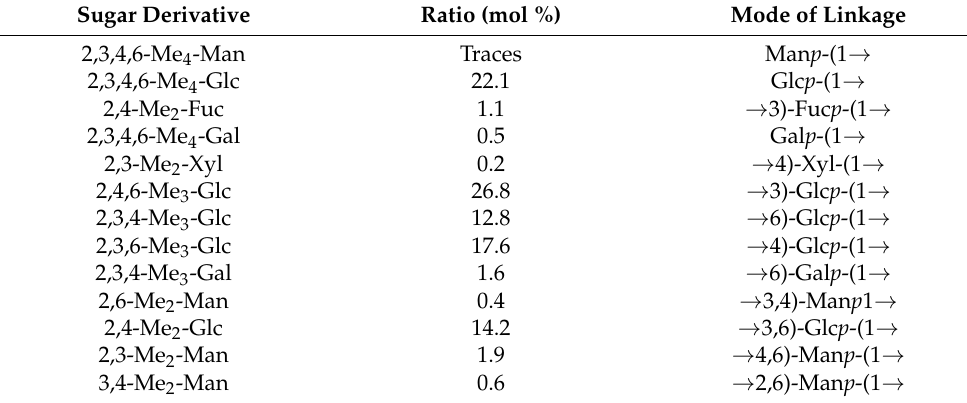
Table 4. Sugar linkage analysis of F2